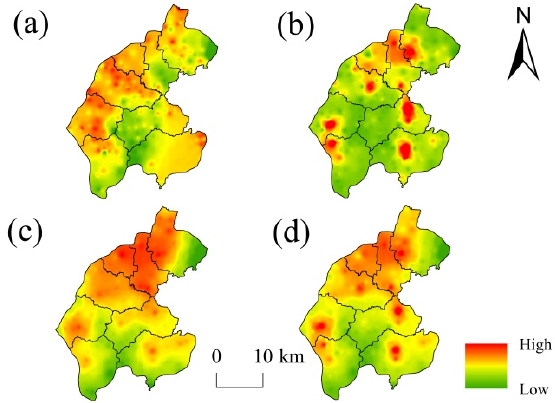
Figure 7. The scores for rural settlements in Pingyin County based on the optimization model. ( a ) Natural conditions; ( b ) socio-economic foundations; ( c ) location advantages; ( d ) RD